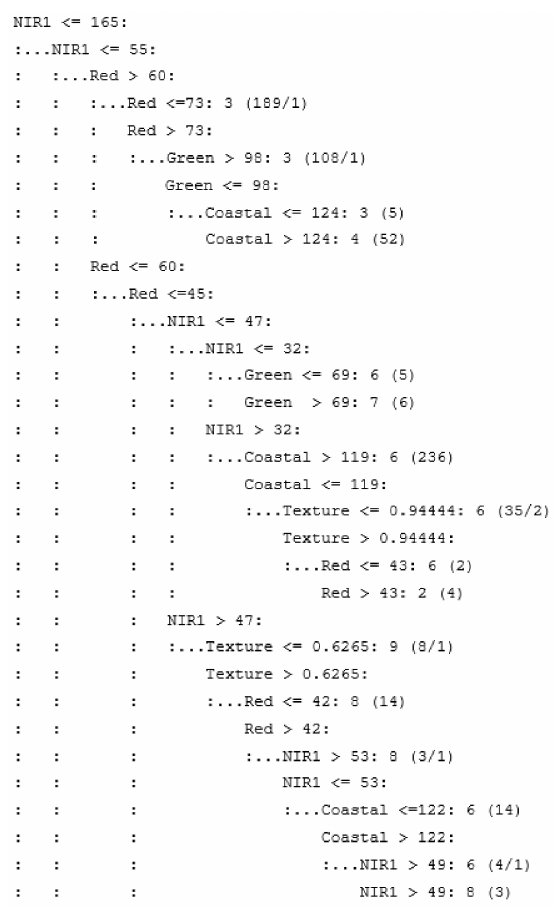
Figure 3. An example of the decision-tree outcome for classifying wetlands of the study